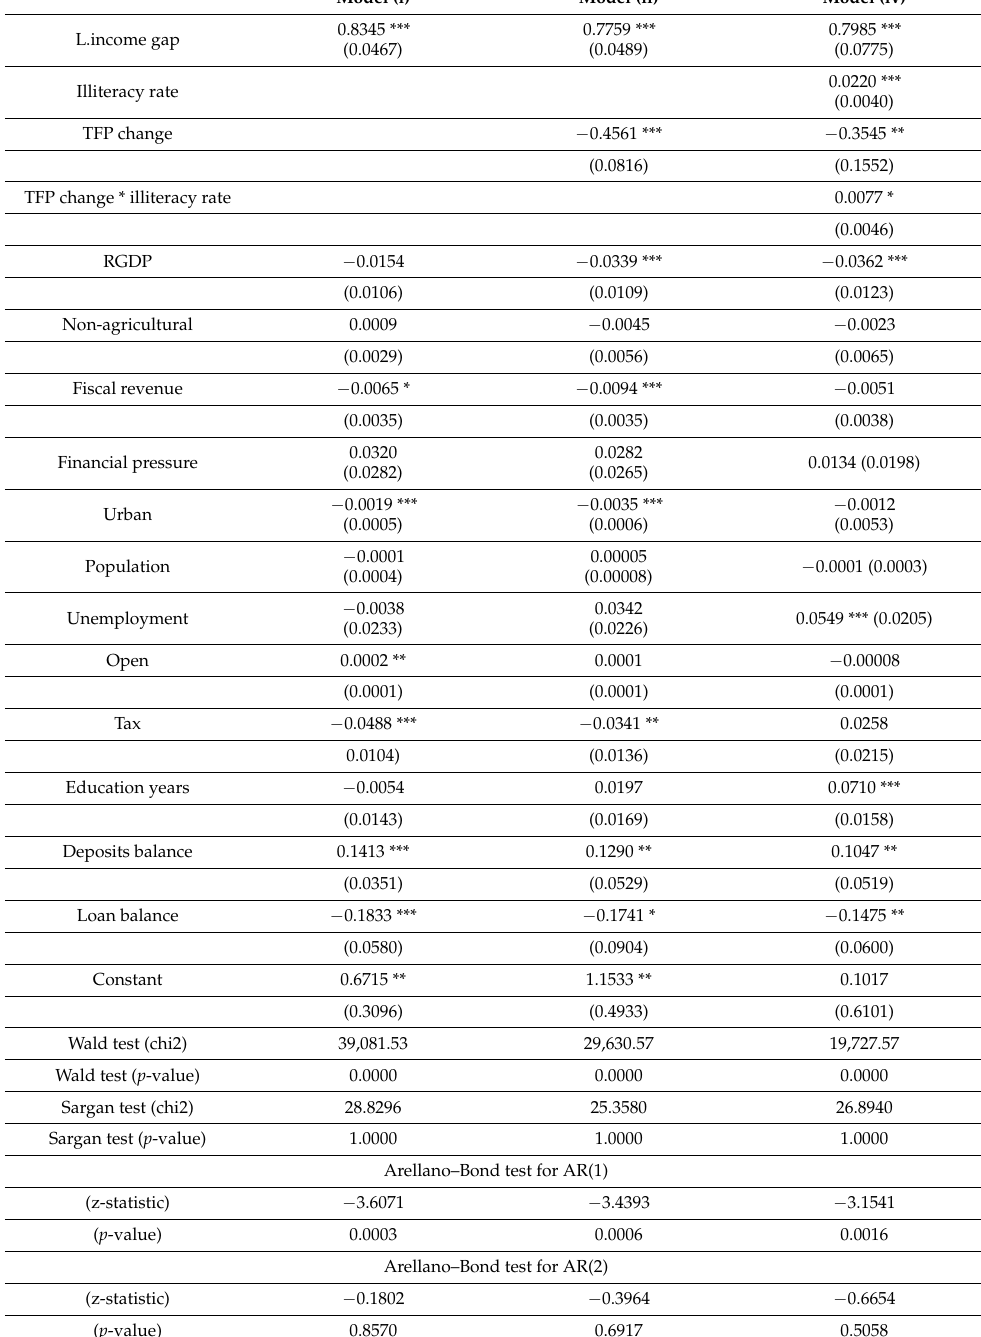
Table 7. The influencing factors of the rural–urban income gap under the interaction